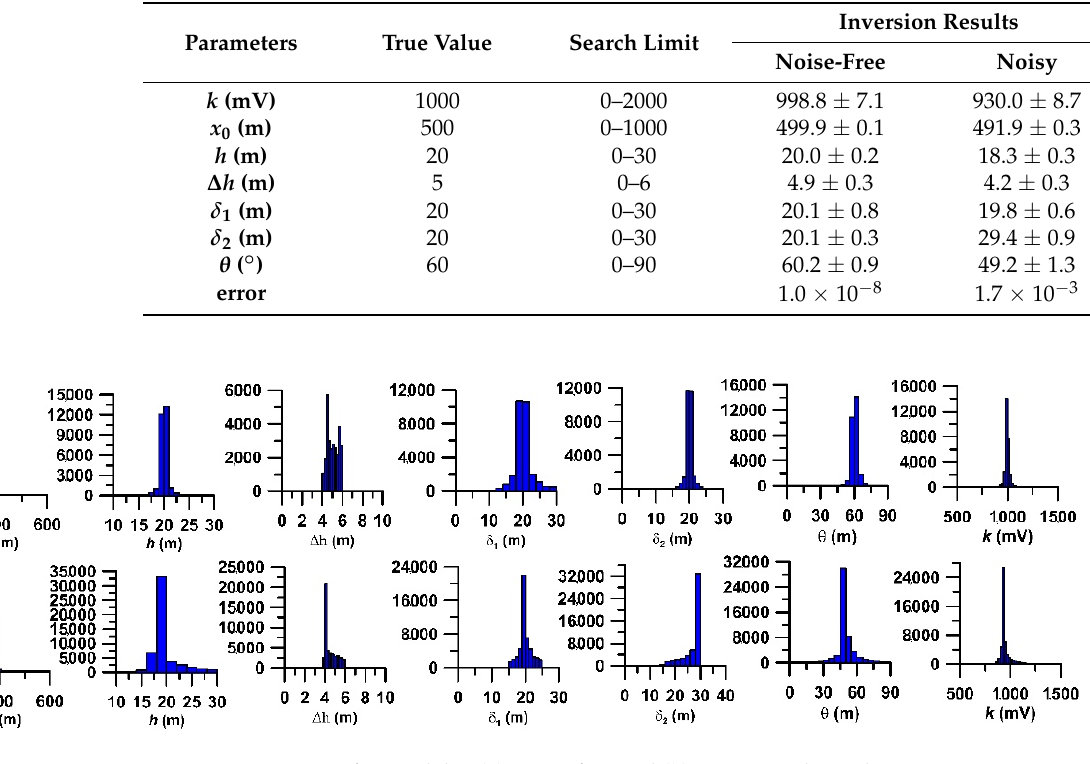
Figure 6. Histogram for Model 2: ( a ) Noise-free and ( b ) Noisy synthetic data.